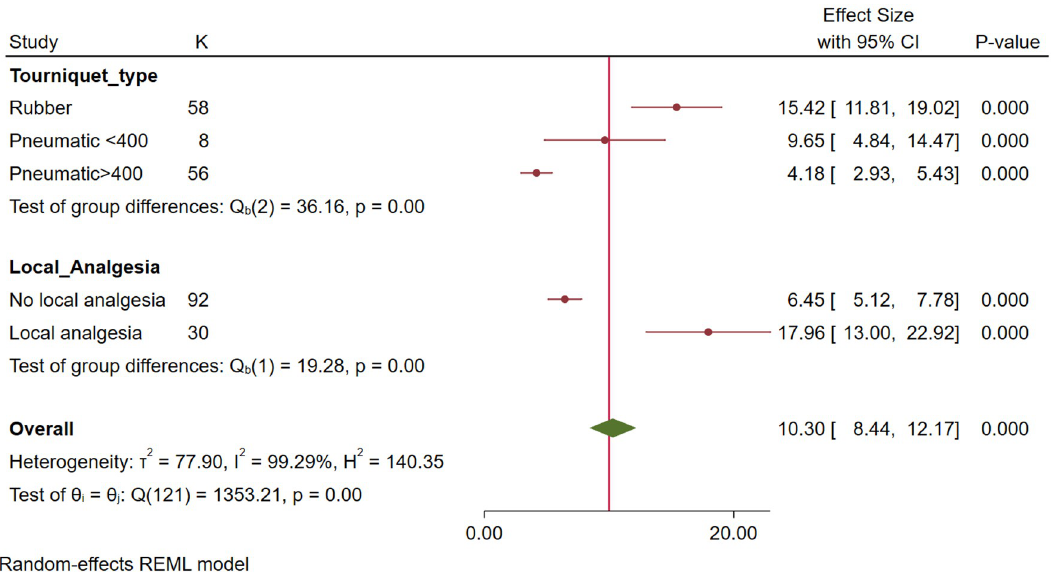
Fig 3. Forest plot by subgroups retained in the final multivariable meta-regression showing concentrations of antibiotics achieved in the synovial structure (multiples of the MIC) for resistant bacteria. Red circles represent point estimates, red horizontal lines represent 95% confidence intervals. The green diamond represents the summary measure θ , but this measure is not considered reliable due to the high heterogeneity between